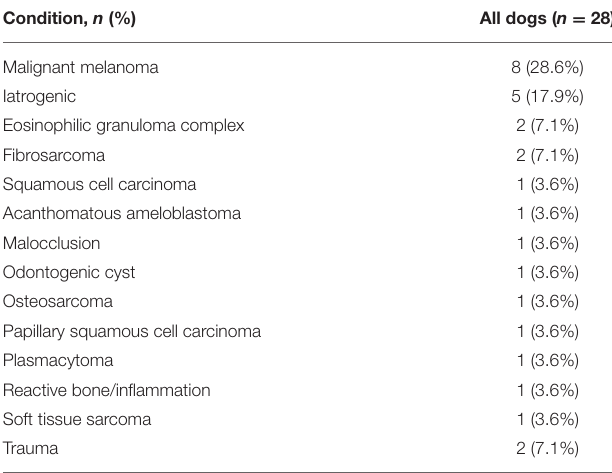
FIGURE 7 | Full vs. partial-thickness flaps. Photograph showing healing following full-thickness elevation of a hard palate mucoperiosteal flap (HPF). Note the oronasal communication at the left palatine fissure as a complication of full-thickness rostral elevation of the HPF. Partial-thickness elevation of the flap in the region of the incisive papilla/palatine fissure may have prevented this complication.